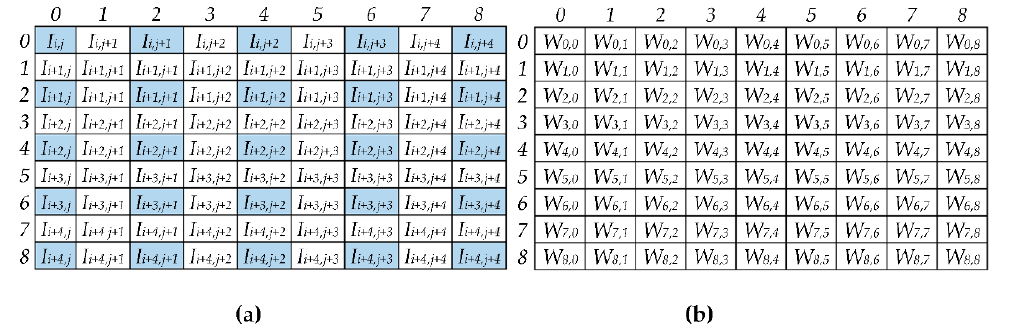
Figure 3. Example of computation with k = 9, S D = 2, and K C = 5: ( a ) The remapped window RI ; ( b ) the filter W .